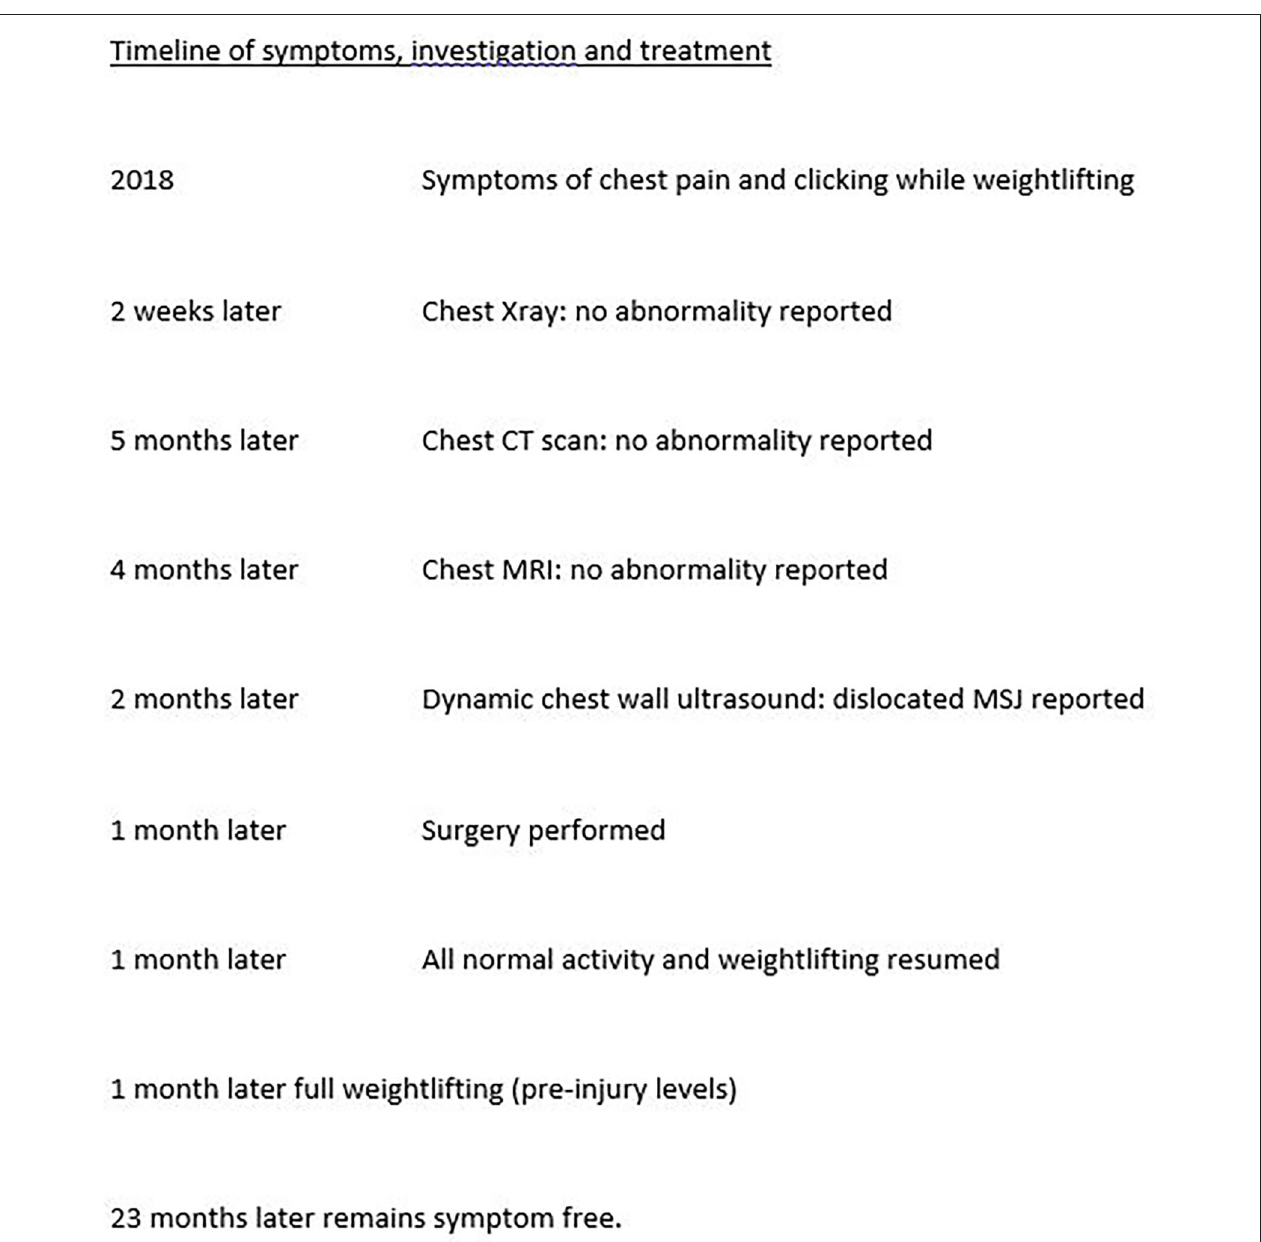
FIGURE 1 | Timeline of symptoms, investigation, and